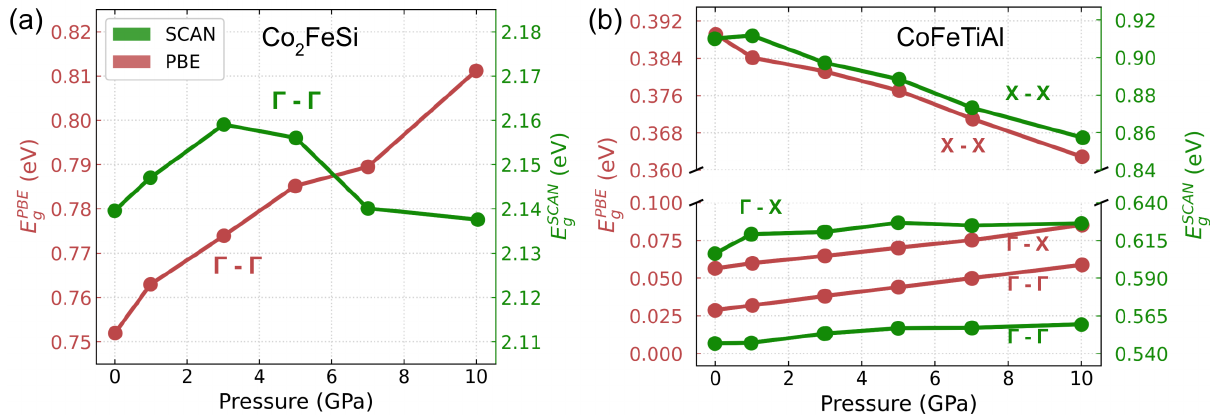
Figure 20. Transition energies between high-symmetry points based on the external pressure for ( a ) Co 2 FeSi and ( b ) CoFeTiAl calculated with the GGA and SCAN